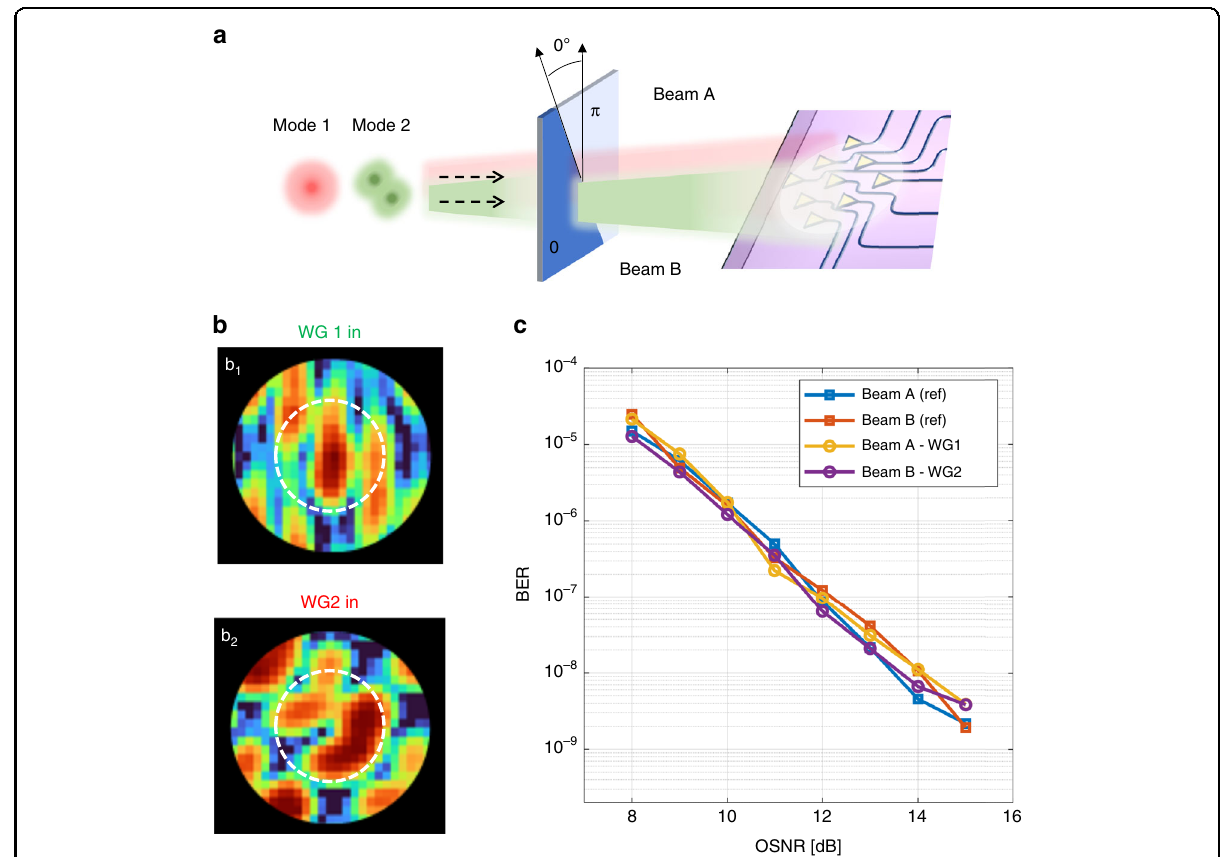
Fig. 5 Mode separation after an arbitrary mode-mixing. a Schematic representation of two free space beams (Beam A and Beam B) that arrive on the receiver after an unknown linear transformation performed by a randomly oriented phase mask acting on two orthogonal modes (Mode 1 is HG00 and Mode 2 is 45° rotated HG10-like). b The shape of Beam A and Beam B can be identi fi ed by observing the backward far- fi eld intensity pattern radiated by the 2D optical antenna array when the photonic processor is con fi gured to couple Beam A to WG1 (b 1 ) and Beam B to WG2 (b 2 ). Circles indicate the position of the zero-order diffraction. c BER measurements of 10 Gbit/s OOK channels simultaneously transmitted on the overlapped Beams A and B and separated by the photonic processor. Blue and red squares indicate the reference BER of individually